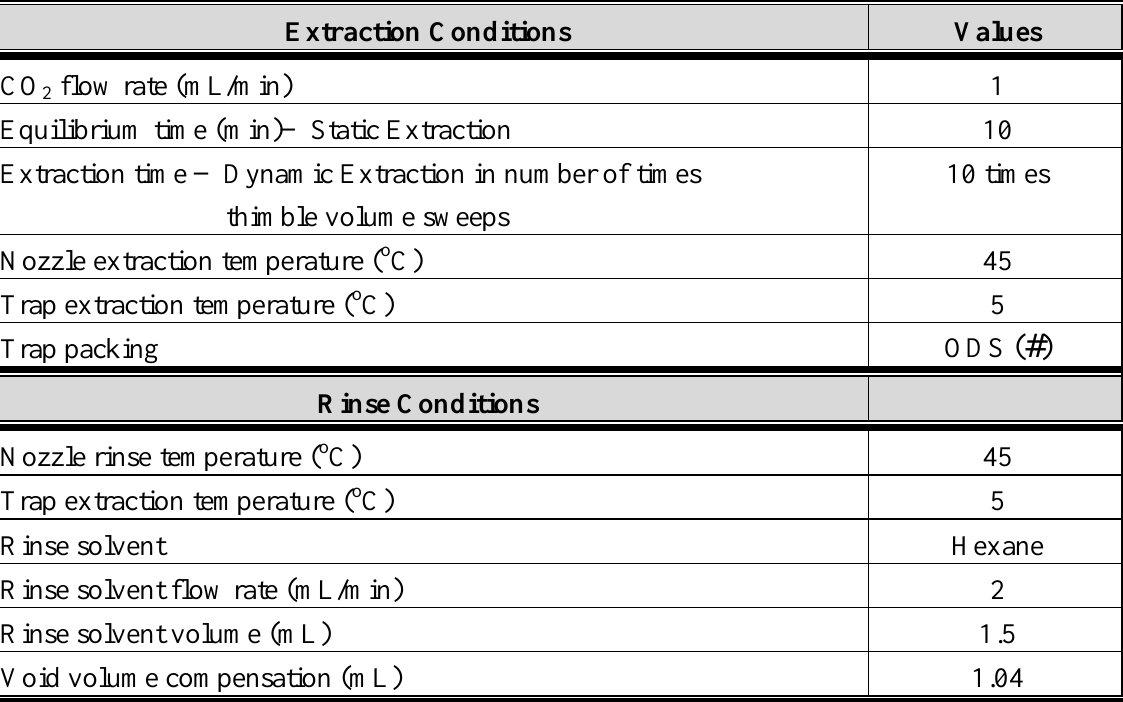
Table 3. SFE parameters that were maintained in all